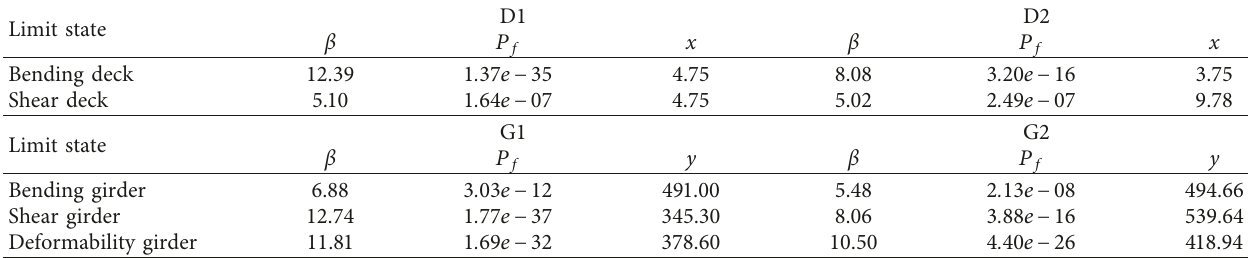
Figure 11: Reliability index β for girders in the two design alternatives: related to the bending limit state (a); to the shear limit state (b); and to the deformability limit state (c). Table 4: Results of the reliability analysis for the two design